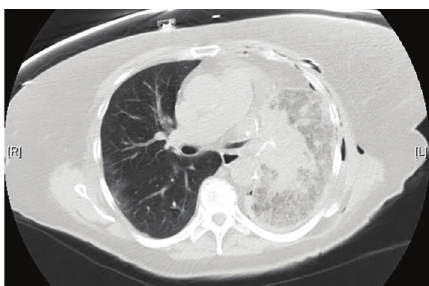
Figure 1: CT of the chest parenchymal view demonstrating a 1.2cm spiculated left upper lobe nodule.